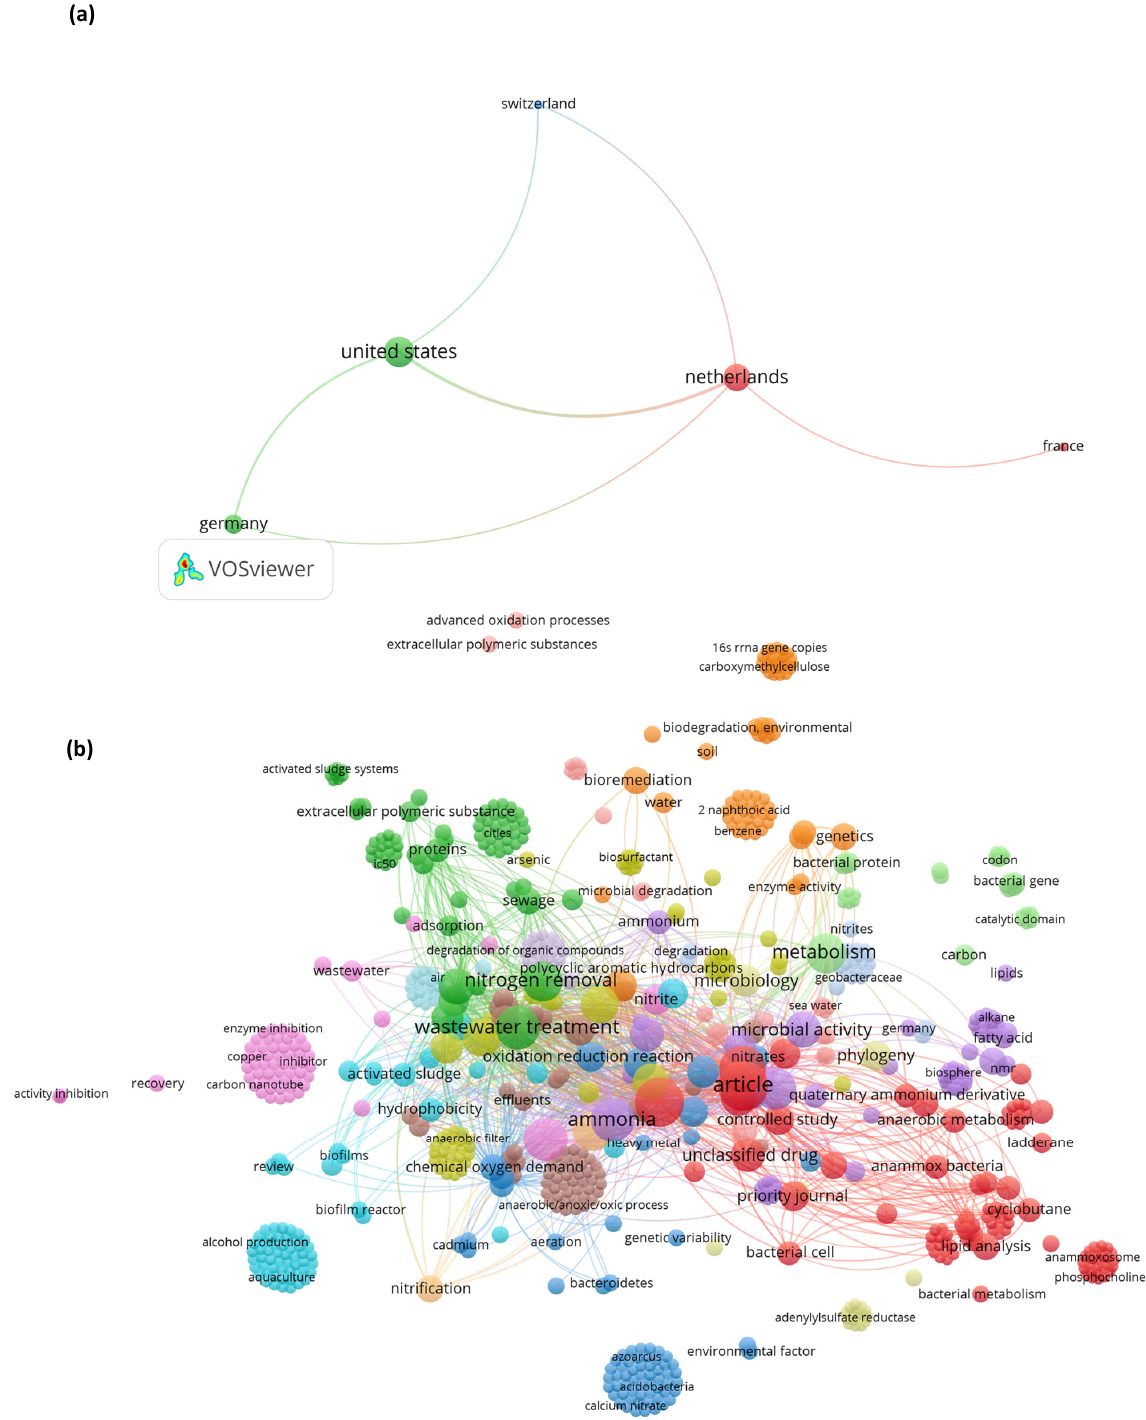
Figure 2. Semiquantitative evaluation of the data collected from the Scopus database using VOSviewer software. The network map shows ( a ) the relations between various countries in the field and ( b ) keyword co-occurrences. The line thickness and circle size represent the correlations between the items. The colors of the lines or circles were obtained according to the colors of the items. Analogous item colors indicate